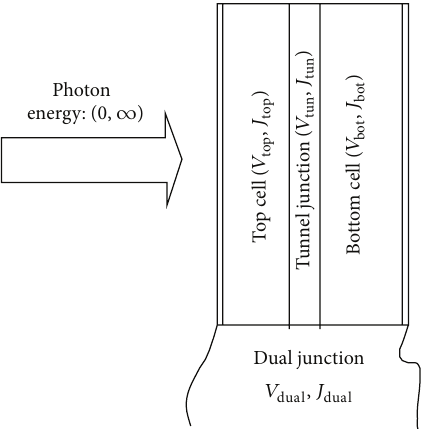
Figure 1: Scheme of the two terminals, of dual-junction solar